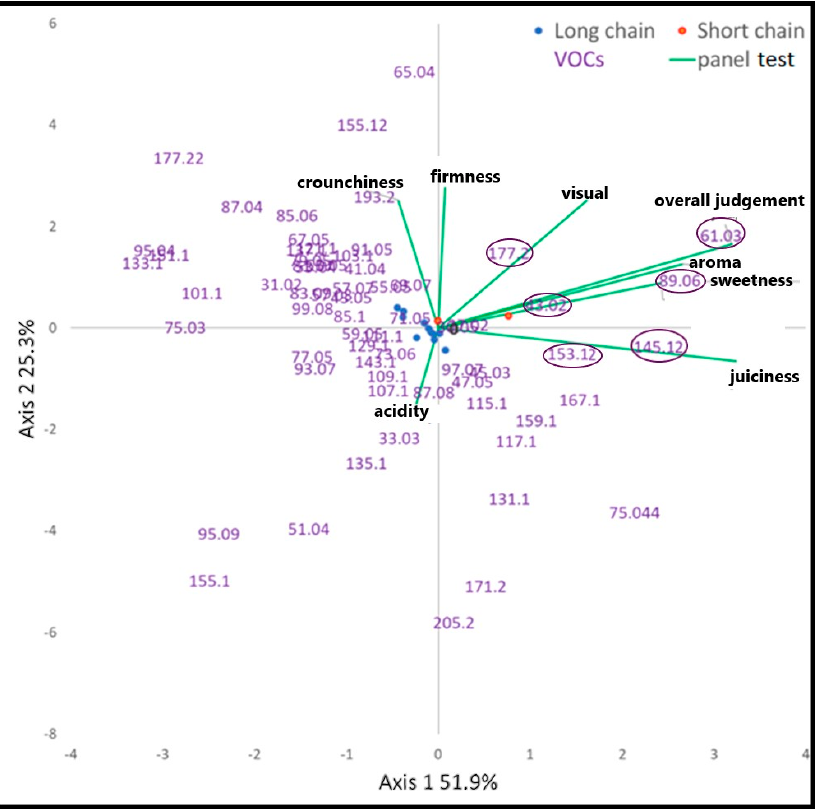
Figure 6. Triplot of the first two axes of the CANOCO conducted on panel test (purple values) and VOCs matrices (green vectors).